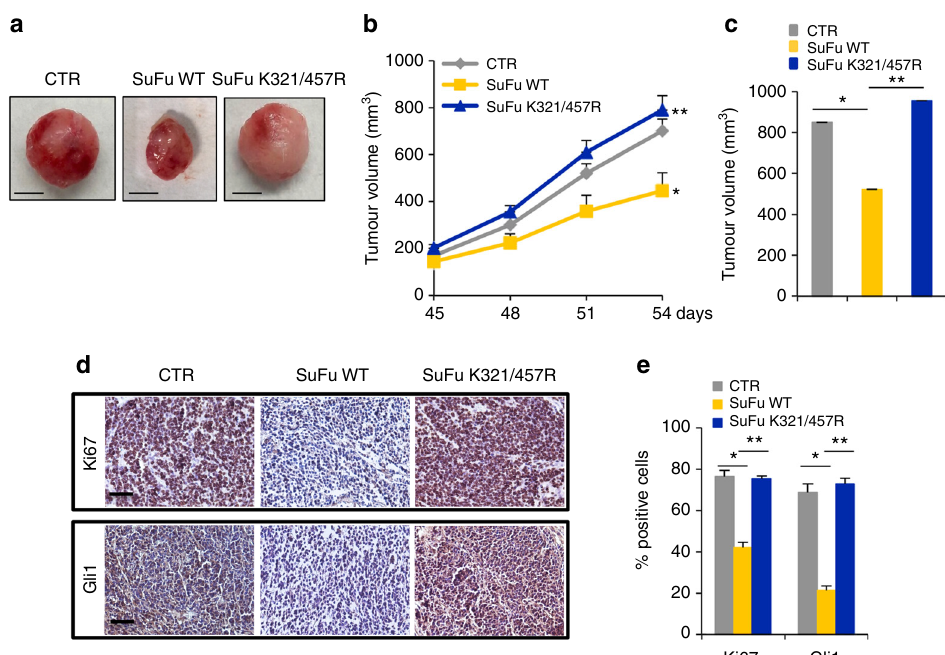
Fig. 8 Mouse Ptch1 + / − MB allografts. a Images of representative CTR, SuFu WT, and SuFu K321/457R fl ank allograft masses ( n = 6 mice for each group) (scale bars = 5 mm). b Tumour volumes were monitored over time by caliper measurements at the indicated times. * P < 0.05, SuFu WT versus CTR; ** P < 0.05, SuFu K321/457R mutant versus SuFu WT. c Tumour volumes were measured post explantation. *P < 0.05, SuFu WT versus CTR; **P < 0.05, SuFu K321/457R mutant versus SuFu WT. d Immunohistochemistry of Ki67 and Gli1 stainings. Scale bars indicate 50 µ m. e Quanti fi cation of Ki67 and Gli1 stainings from immunohistochemistry. * P < 0.05, SuFu WT versus CTR and ** P < 0.05, SuFu K321/457R mutant versus SuFu WT, for Ki67 staining quanti fi cation. * P < 0.05, SuFu WT versus CTR and ** P < 0.01, SuFu K321/457R versus SuFu WT, for Gli1 staining quanti fi cation. Error bars indicate SD.